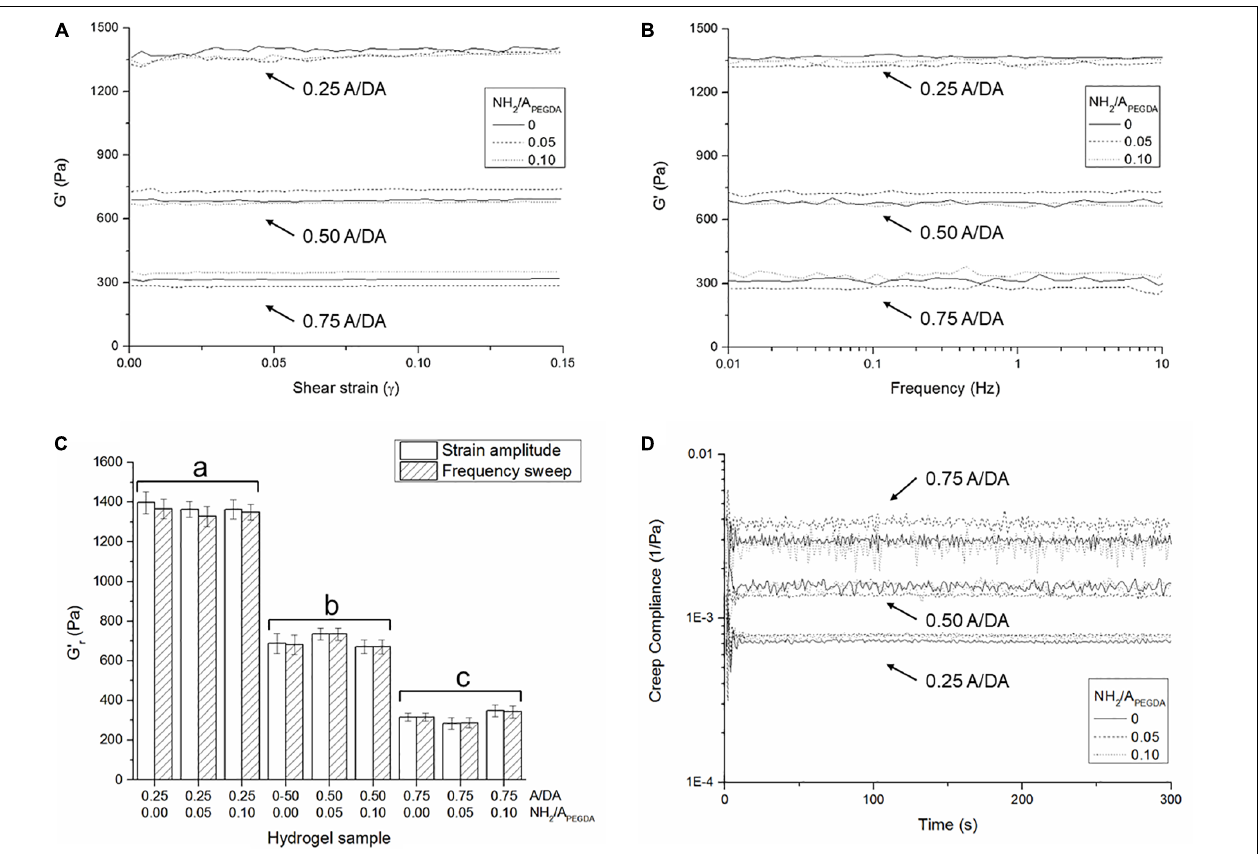
FIGURE 2 | Averaged storage shear moduli ( n = 3 independent samples per formulation) measured as a function of (A) shear strain and (B) applied frequency, for all investigated hydrogel formulations. (C) Hydrogel shear storage moduli in the relaxed state ( G (cid:48) r ) derived from both strain amplitude and frequency sweep measurements. Different letters indicate significant differences between samples (one-way ANOVA, p < 0.05). (D) Shear creep compliance during the creep phase. Note that the initial oscillations at the beginning of the creep experiments are likely due to the inertia of the measuring instrument (Baravian and Quemada,